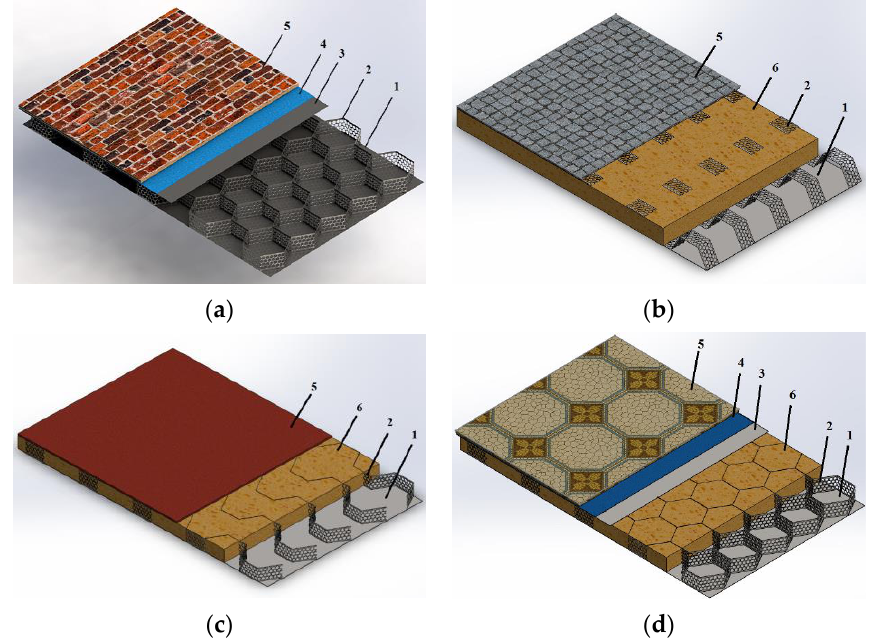
Figure 8. Sandwich panels with the PMM core, ( a ) external panel without heat insulation: ( b , c ) internal panel with heat or sound insulation; ( d ) ceiling panel; 1—bottom flange; 2—perforated profile; 3—load distribution layer; 4—damping layer or adhesive layer; 5—finishing layer; 6—heat or sound insulation [44].